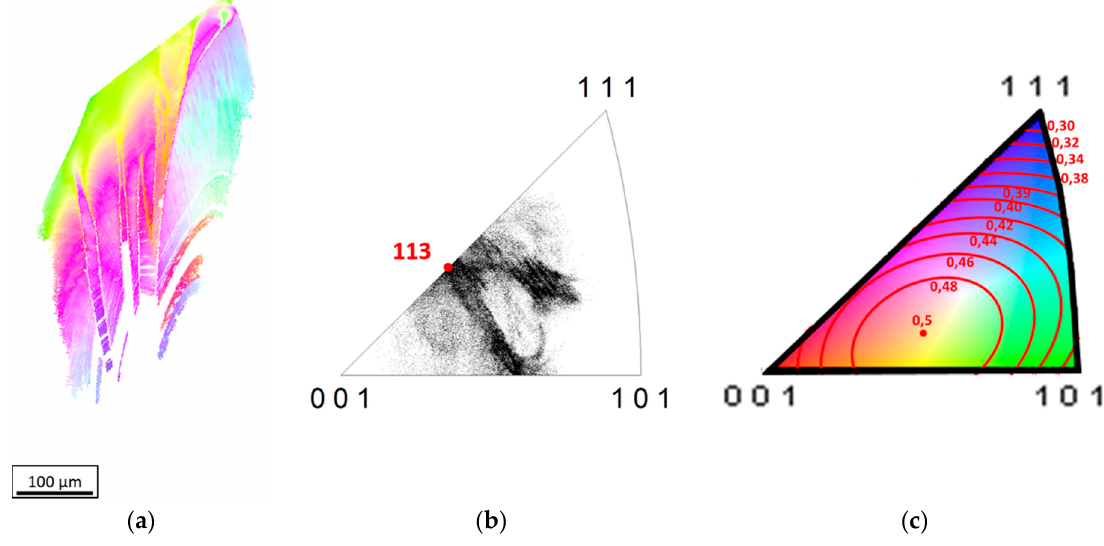
Figure 12. ( a ) IPF||RD mapping of the fractured grain from the solution annealed wire in Figure 8. ( b ) Inverse pole figures overlapped with the crystallographic orientation of all measured point within the fractured grain and ( c ) Schmid factor intervals linked with the crystallographic orientation in the inverse pole figure.